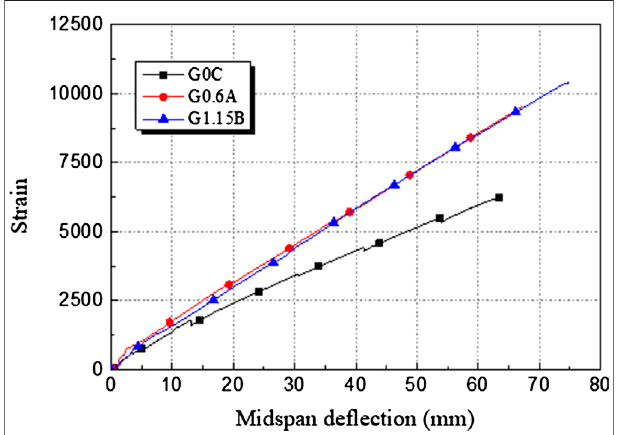
FIGURE 15 | Distribution of strain in the midspan